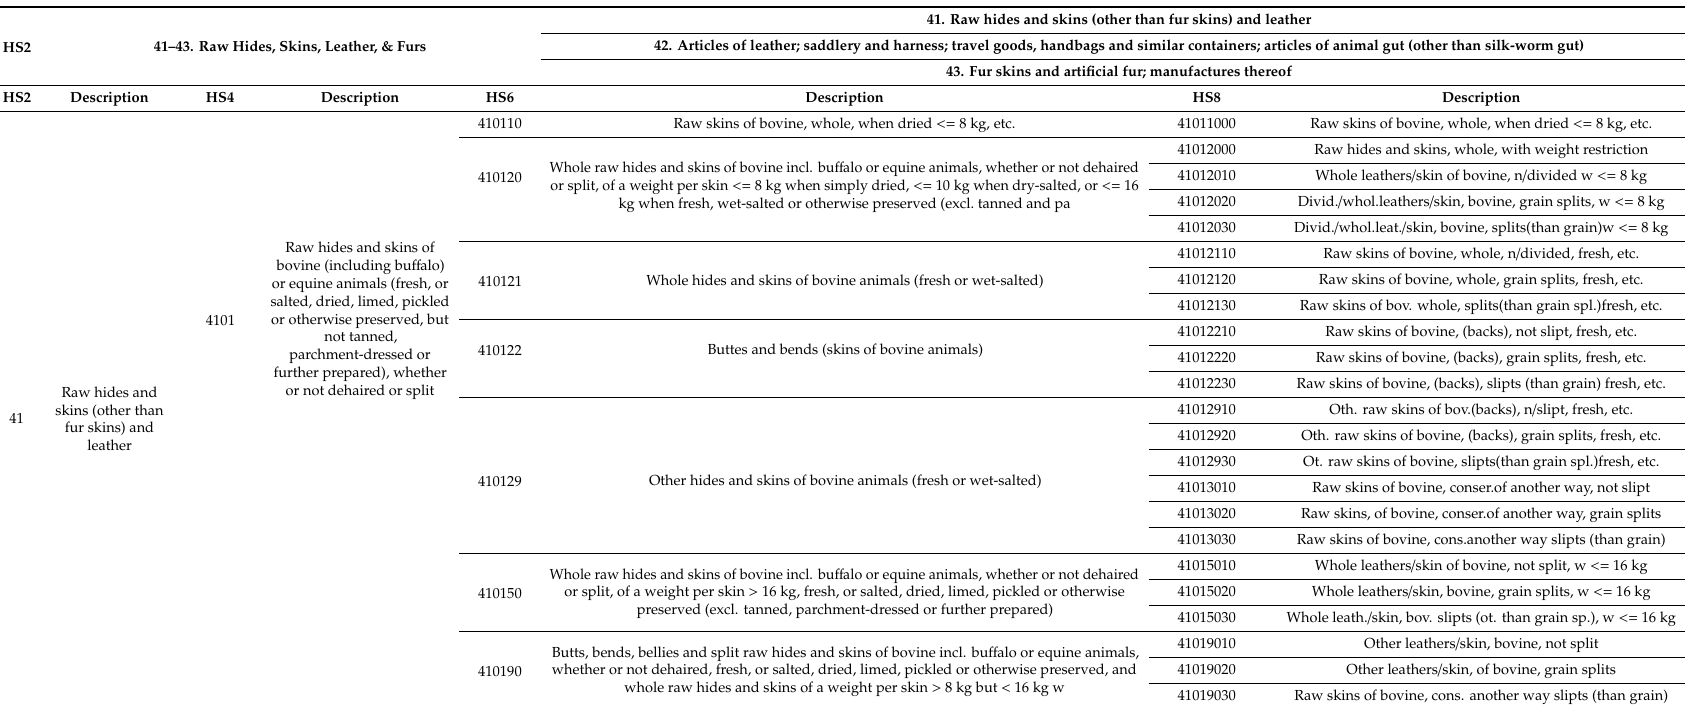
Table A1. The list of the Harmonized Commodity Description and Coding Systems (HS) applicable to the case of bovine leather [25]. HS2 41–43.